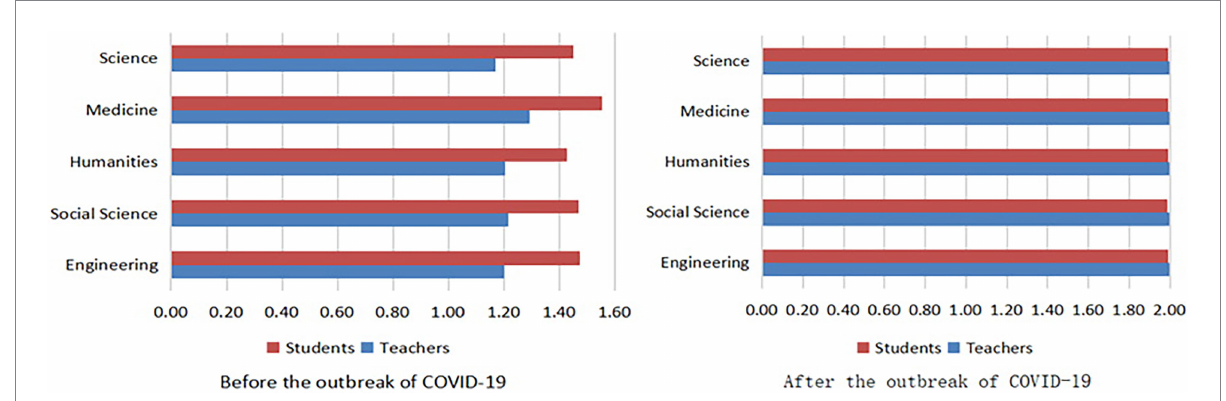
FIGURE 1 Implementation of online learning reported by teachers and students from different disciplines before and after the outbreak of